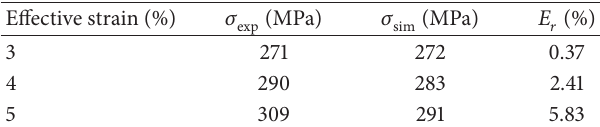
Figure 14: Number of cycle effects on overstress amplitude for a 316 stainless steel. Table 1: Comparison between experimental and simulated stresses at various effective strains with a prior creep strain of